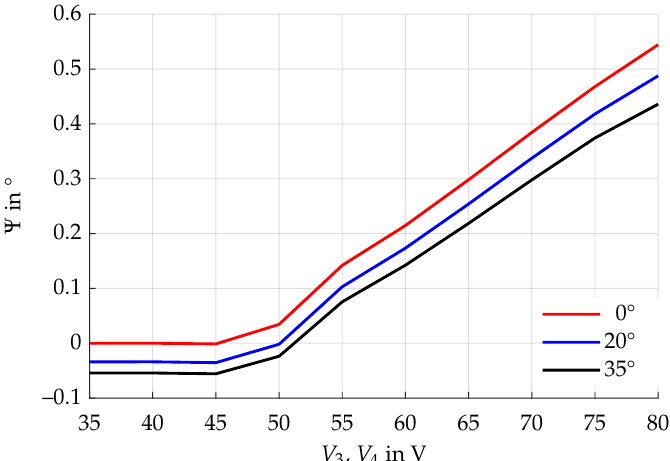
Figure 10. Rotation width for different beam voltages for initial deflections α = 0, 20, 35°. This can be used to obtain a higher accuracy. The rotation width slightly decreases with larger initial rotation of the